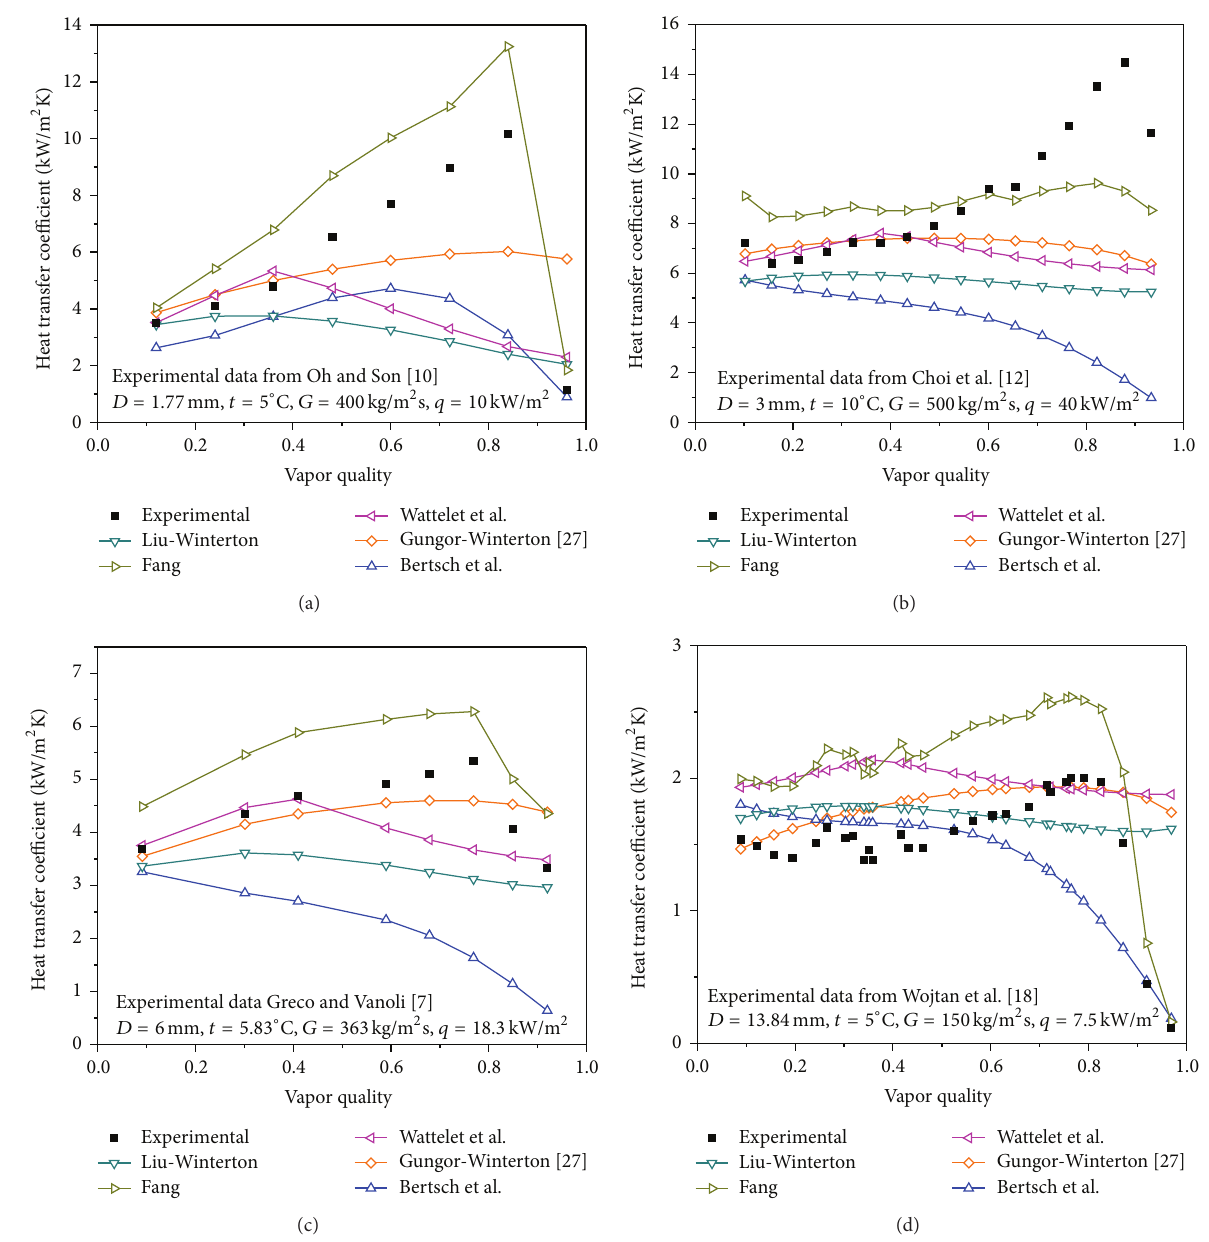
Figure 8: Effect of vapor quality on flow boiling heat transfer of R22: predicted versus